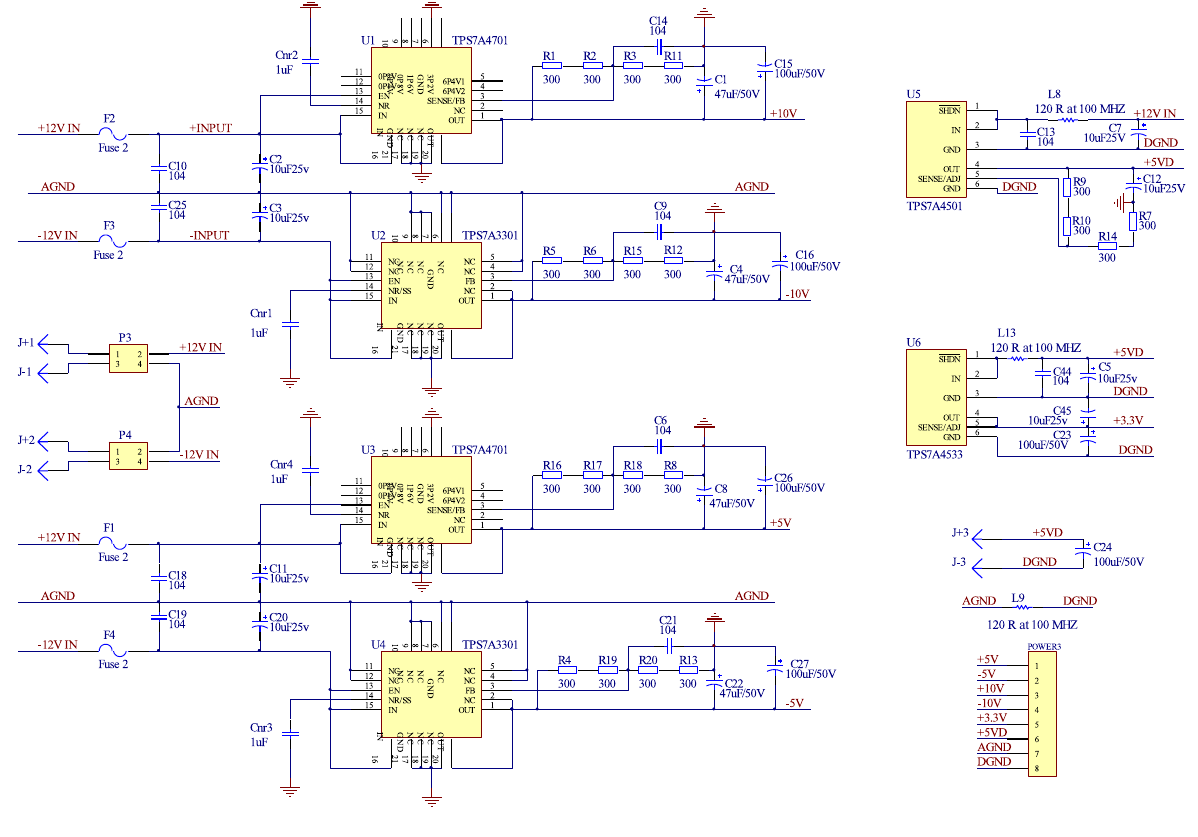
Figure 9. High-precision power